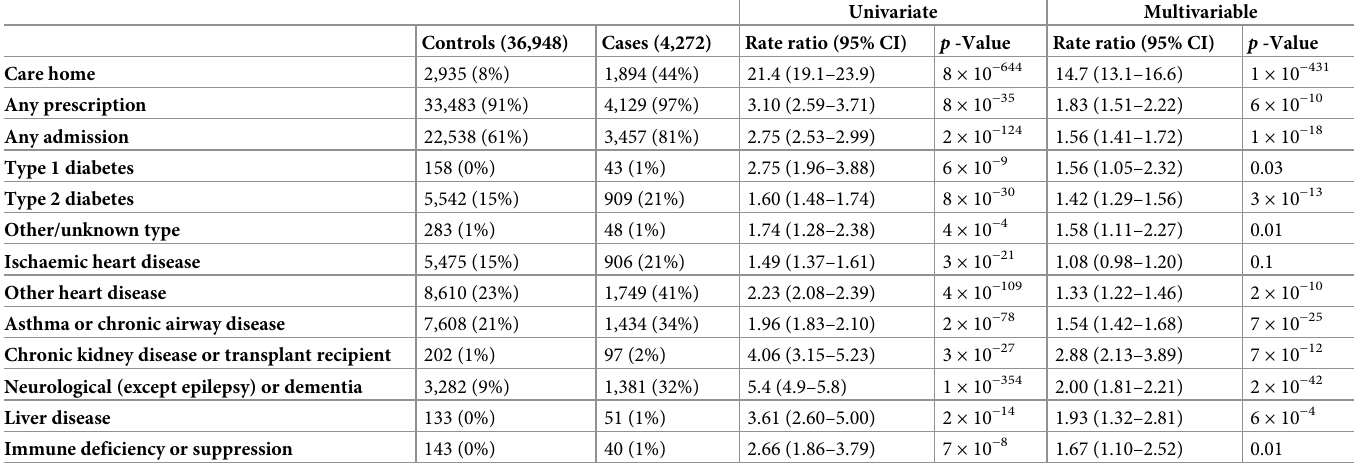
Table 3. Associations of severe disease with listed conditions over all age